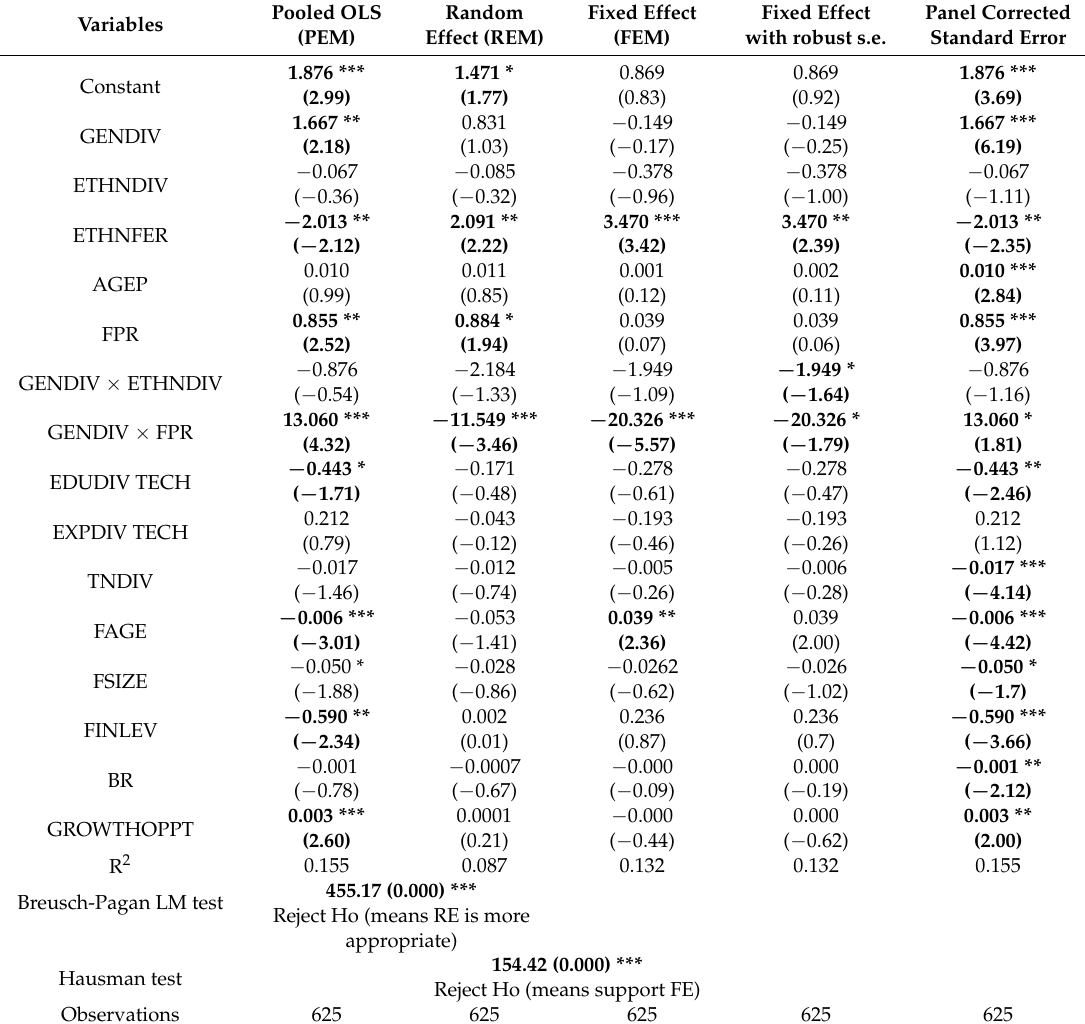
Table 4. Regression analyzes (125